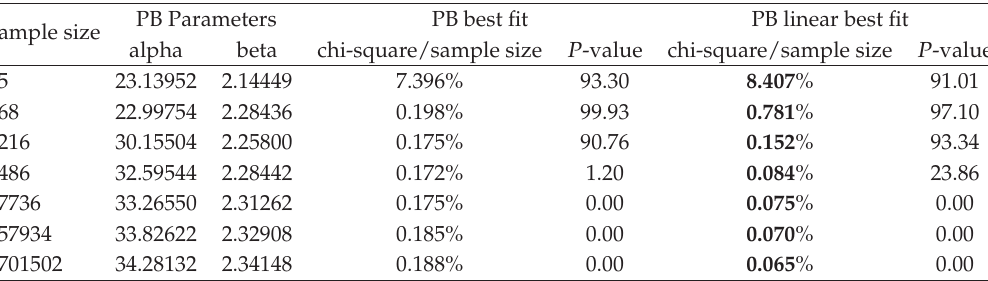
Table 5: Best and linear best Pareto Benford fit for prime number sequences. Sample